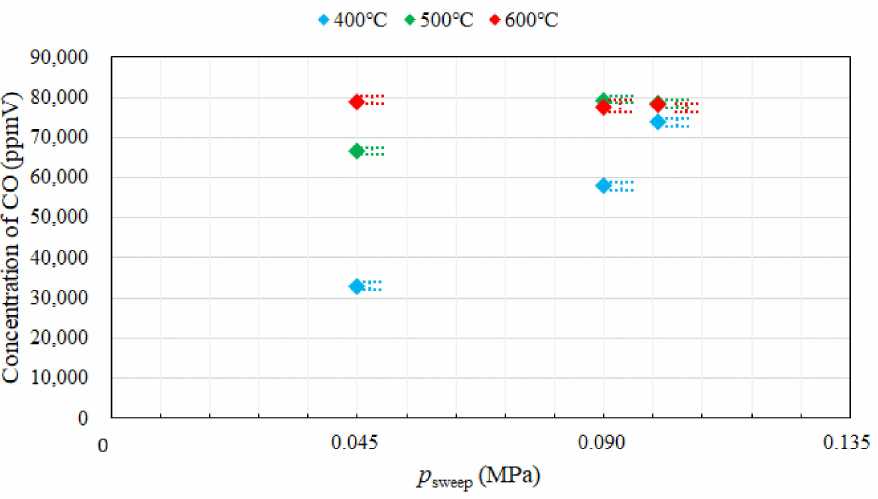
Figure 5. Impact of concentration of CO at the outlet of reaction chamber and p sweep with change in.reaction temperature. (CH 4 :CO 2 =